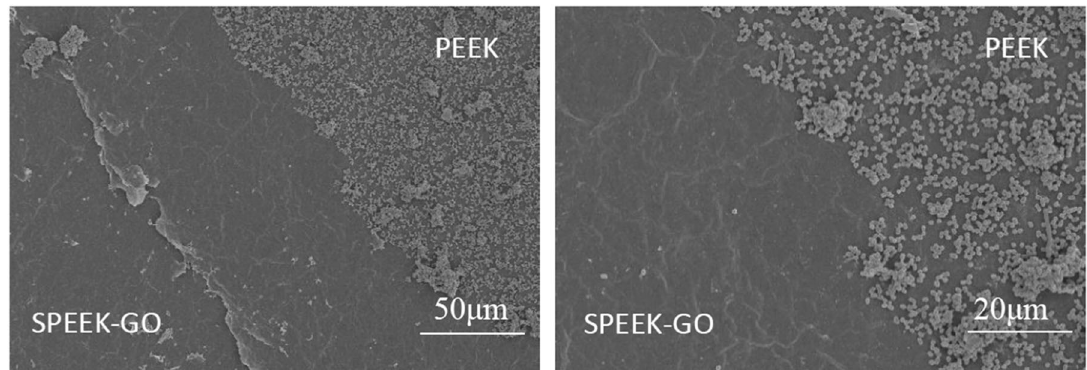
Fig. 10 SEM image of P. gingivalis bio fi lm on the SPEEK-GO sample surface. SPEEK-GO and PEEK were placed on the same specimen for bacterial culture to reduce the operating error